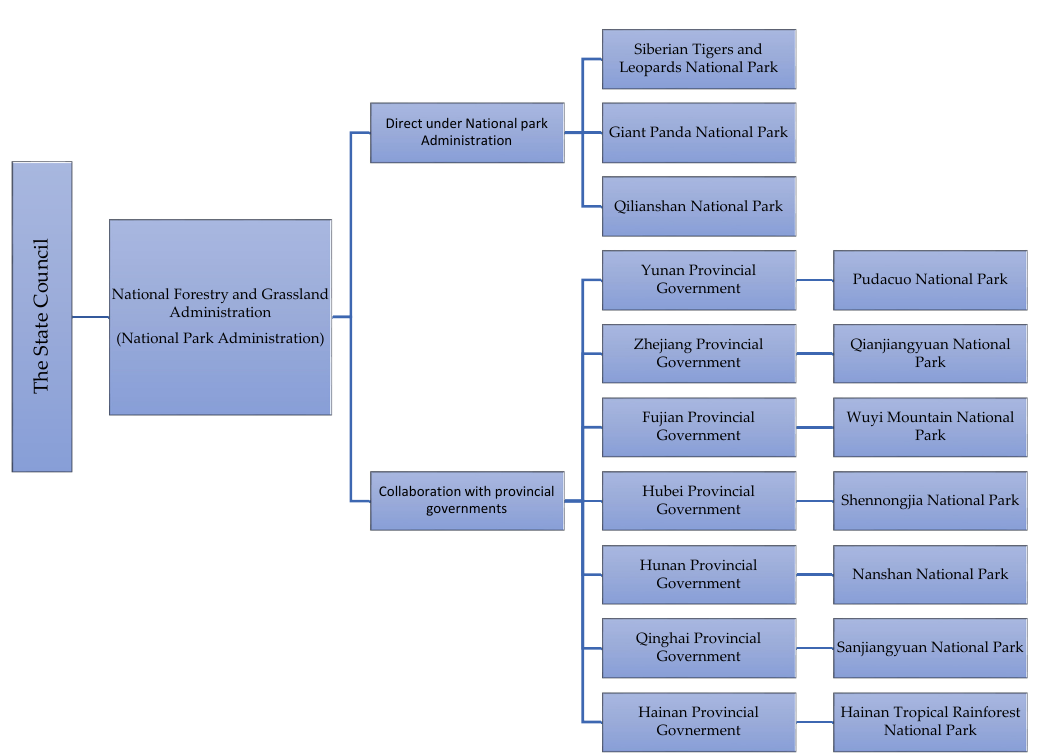
Figure 4. The pilot national park (PNP) institution structure in China (source from [20]). Five national parks (Sanjiangyuan, Wuyi Mountain, Shennongjia, Nanshan, and Qianjiangyuan)